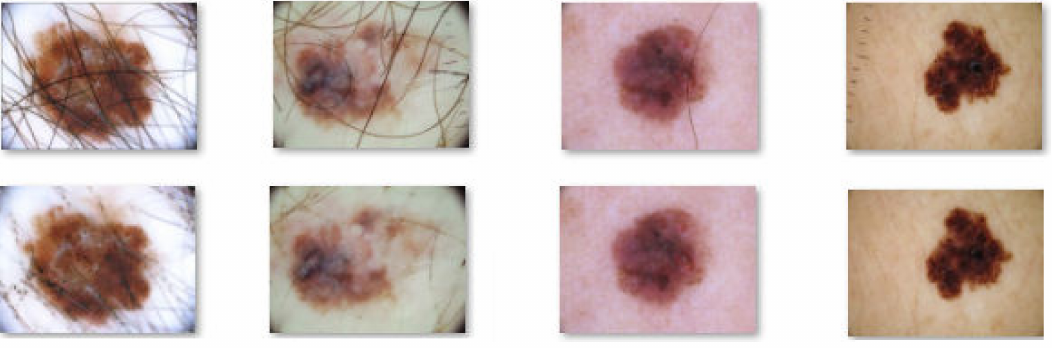
Figure 4. Results obtained after applying the DullRazor algorithm on melanoma